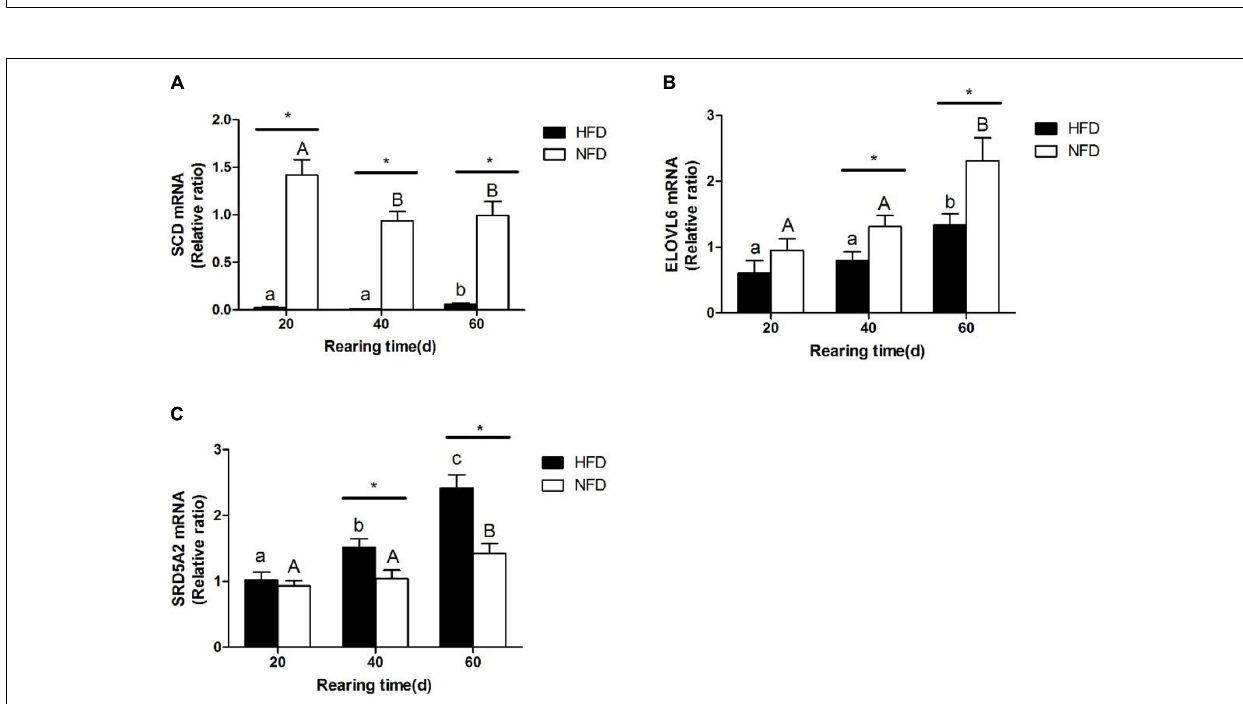
FIGURE 7 | Expression levels of (A) SCD mRNA; (B) ELOVL6 mRNA, and (C) SRD5A2 mRNA in liver of GIFT fed experimental diets on days 20, 40, and 60 ( n = 9 replicates per group). Significant differences ( P < 0.05) between high-fat diet (HFD) and normal-fat diet (NFD) groups at same sampling time are marked by asterisks ( ∗ ). Different superscript lowercase letters show significant differences ( P < 0.05) in HFD group among different sampling times. Different superscript uppercase letters show significant differences ( P < 0.05) in NFD group among different sampling times.